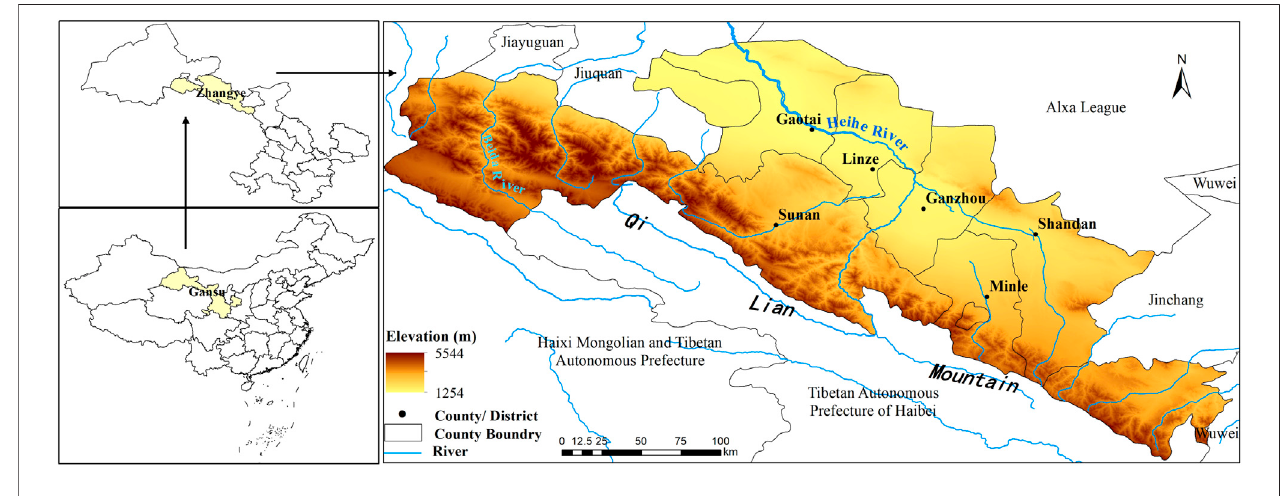
FIGURE 2 | Geographical location of Zhangye city.